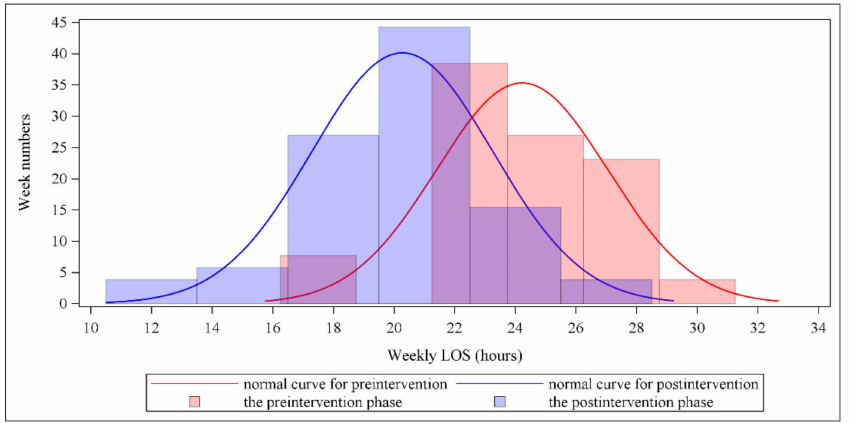
Figure 3. Comparison of weekly LOS for ED admitted patient visits between the preintervention and postintervention phases.